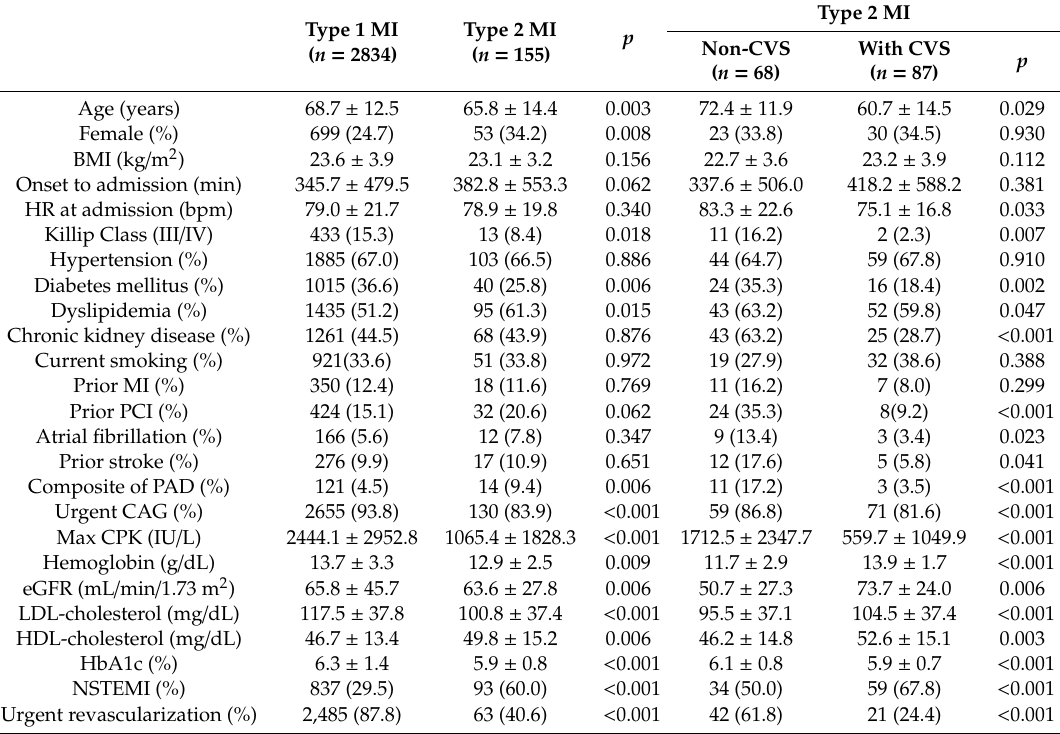
Table 1. Baseline patient characteristics.